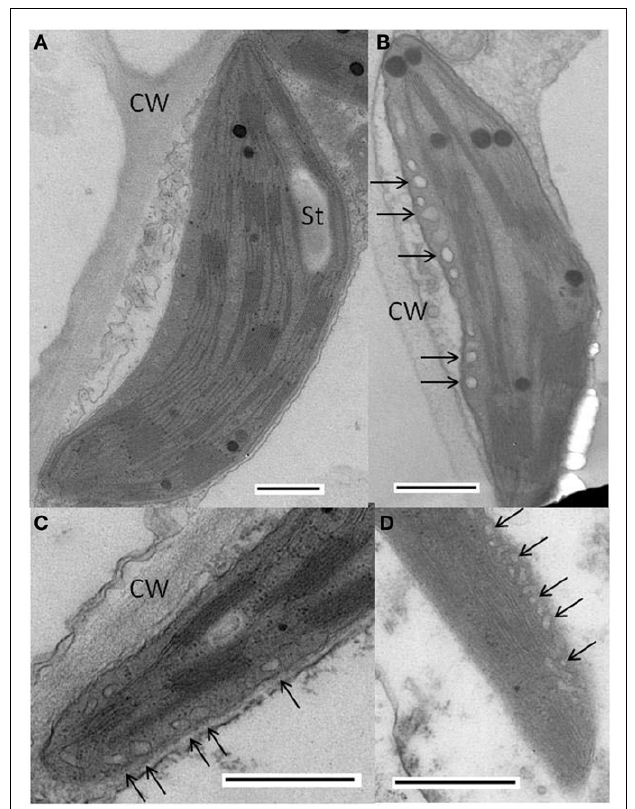
FIGURE 4 | Cytopathology associated withAltMVTGB3 over-expression. (A) Normal chloroplast in thin section of N. benthamiana infected with PVX. (B,C) Vesicles (arrows) observed in chloroplast of N. benthamiana infected with PVX over-expressing AltMVTGB3 as an added gene. (D) Vesicles (arrows) in chloroplast of N. benthamiana infected with AltMV over-expressing AltMVTGB3 as an added gene. CW, cell wall; St, starch. Scale bars in each panel = 500nm.